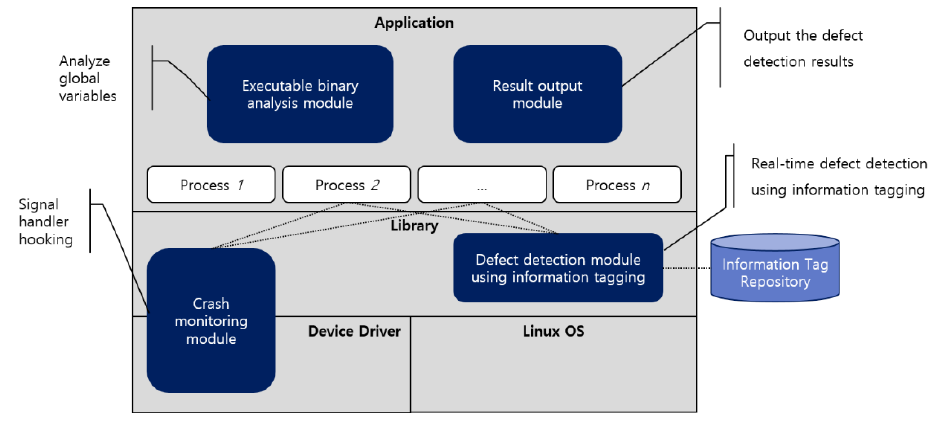
Figure 10. Use of the tool (memory corruption detection tool); ( a ) automation of defect-detection; ( b ) tool execution window.